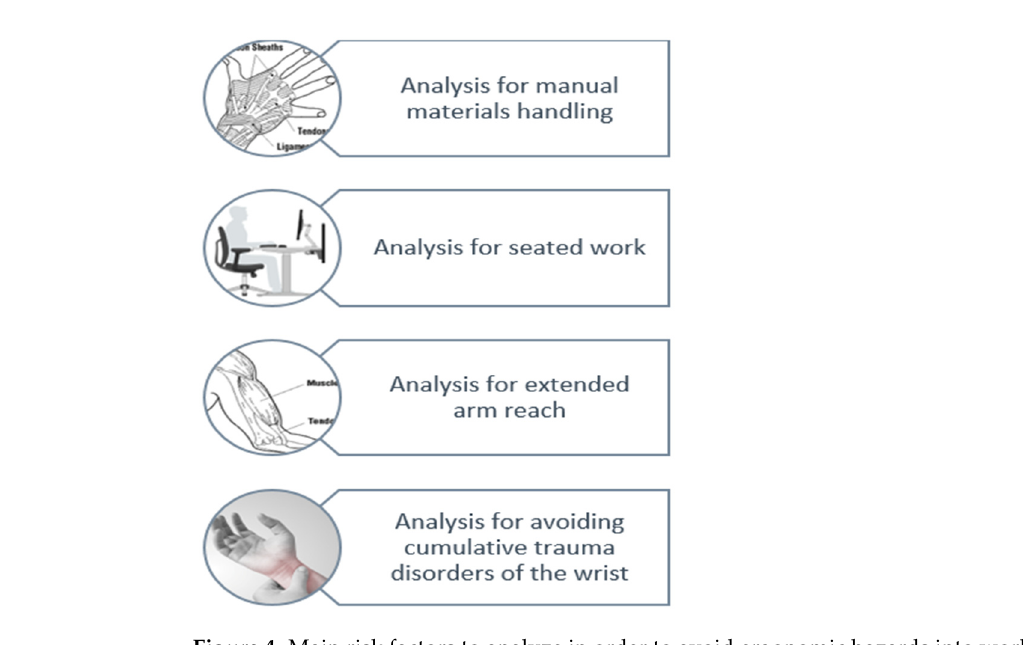
Figure 3. Workplace evaluation method.